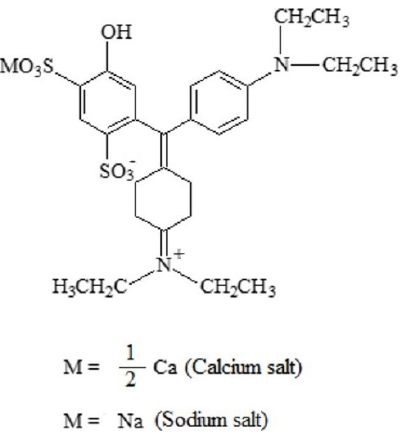
Figure 23. Structural formula of the main components of patent blue V (E131).